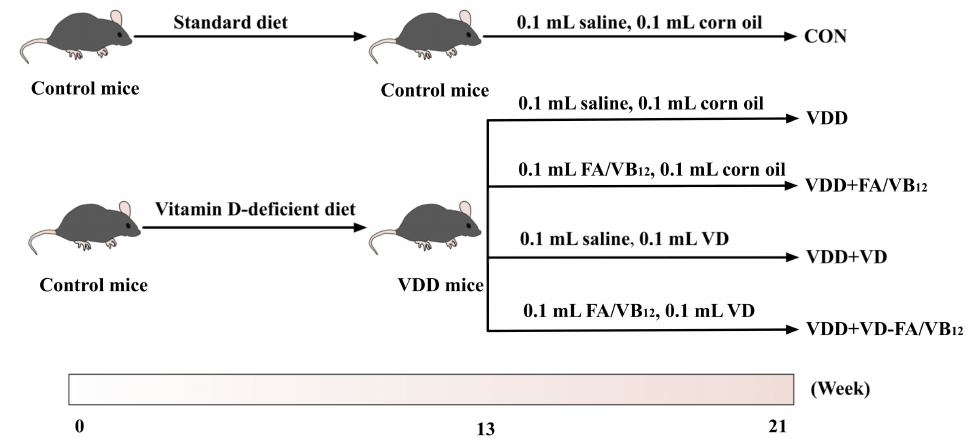
Figure 1. The flow chart. CON: control; VDD: vitamin D-deficient diet; VDD + FA/VB 12 : vitamin D-deficient diet plus folic acid/vitamin B 12 supplement; VDD + VD: vitamin D-deficient diet plus vitamin D supplement; VDD + VD-FA/VB 12 : vitamin D-deficient diet plus vitamin D and folic acid/vitamin B 12